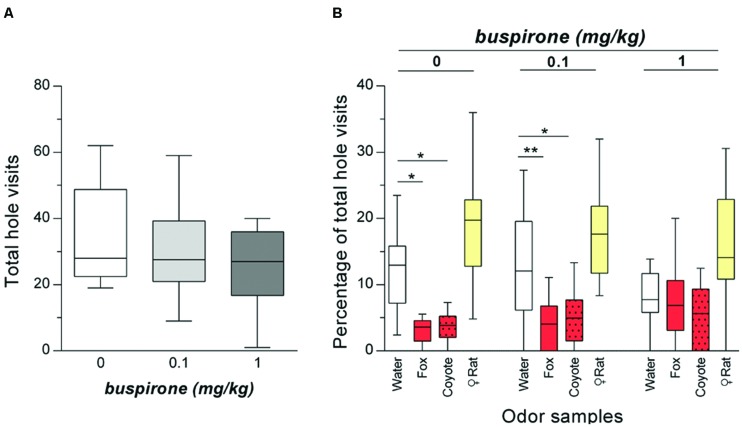
Buspirone treatment specifically blocked the avoidance of holes with carnivore urine without sedating the rats (n = 14). (A) Total number of hole visits (median) of rats after treatment with buspirone (0; 0.1; 1 mg/kg buspirone). (B) Percentages of total hole visits (median) for the different corner holes and for each treatment are shown. ∗p < 0.05; ∗∗p < 0.01 comparison as indicated (Holm-Sidak’s/Dunn’s multiple comparison test after significant main effects in an ANOVA/Friedman test).